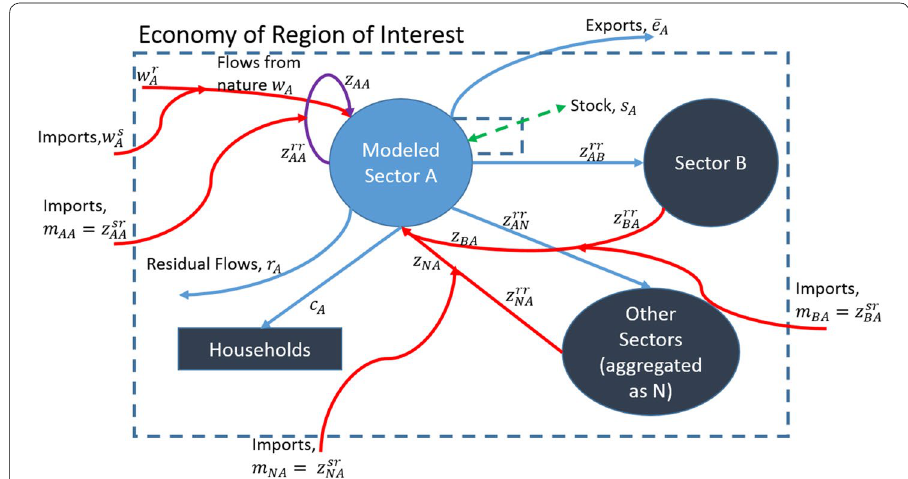
Fig. 2 Flows between a single production sector A and the rest of the economy. Flows to and from stocks are shown with a dotted line. The temporal and regional boundaries are dashed boxes. Incoming flows to sector A are red, while outgoing flows are blue. The self-flow is shown as purple. Note that in the figure x r